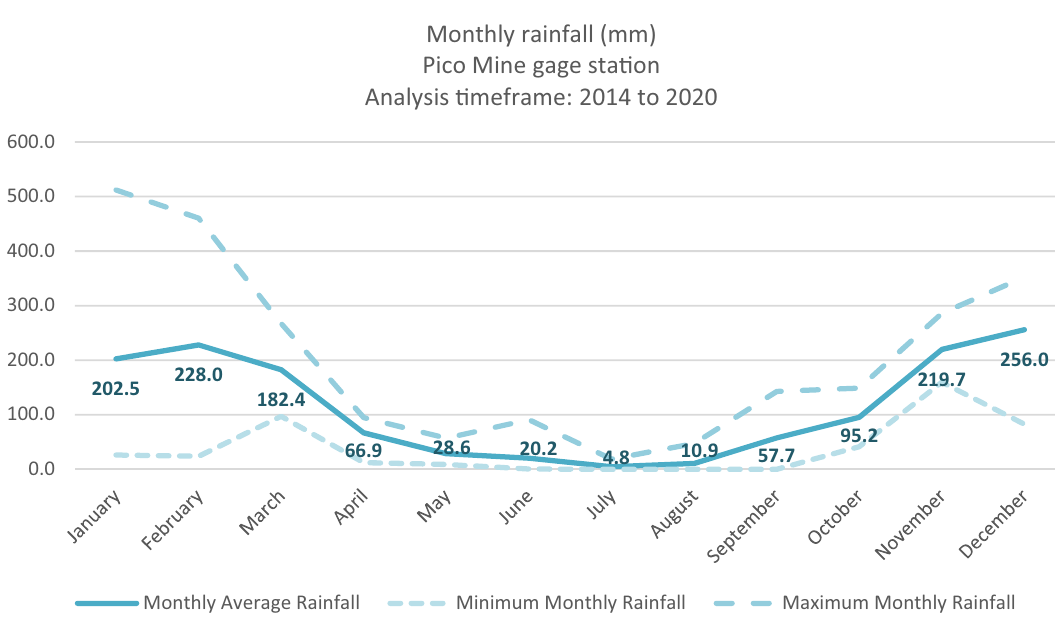
Fig. 2 Monthly average rainfall (continuous line); dotted lines rep- resent the minimum and the maximum monthly value recorded in the period. Source of data: Vale, internal report. Statistics corre-